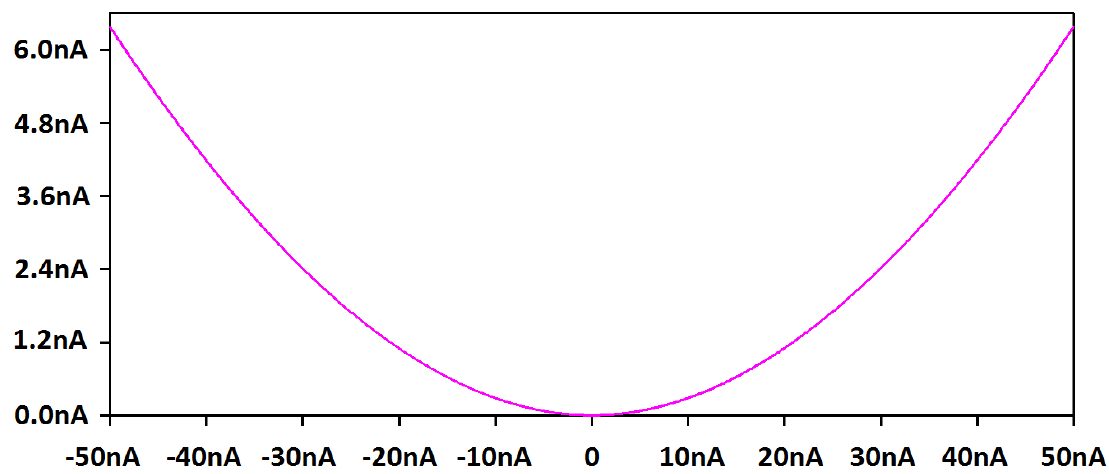
Figure 4. The simulated I C ( I B ) squaring characteristic from